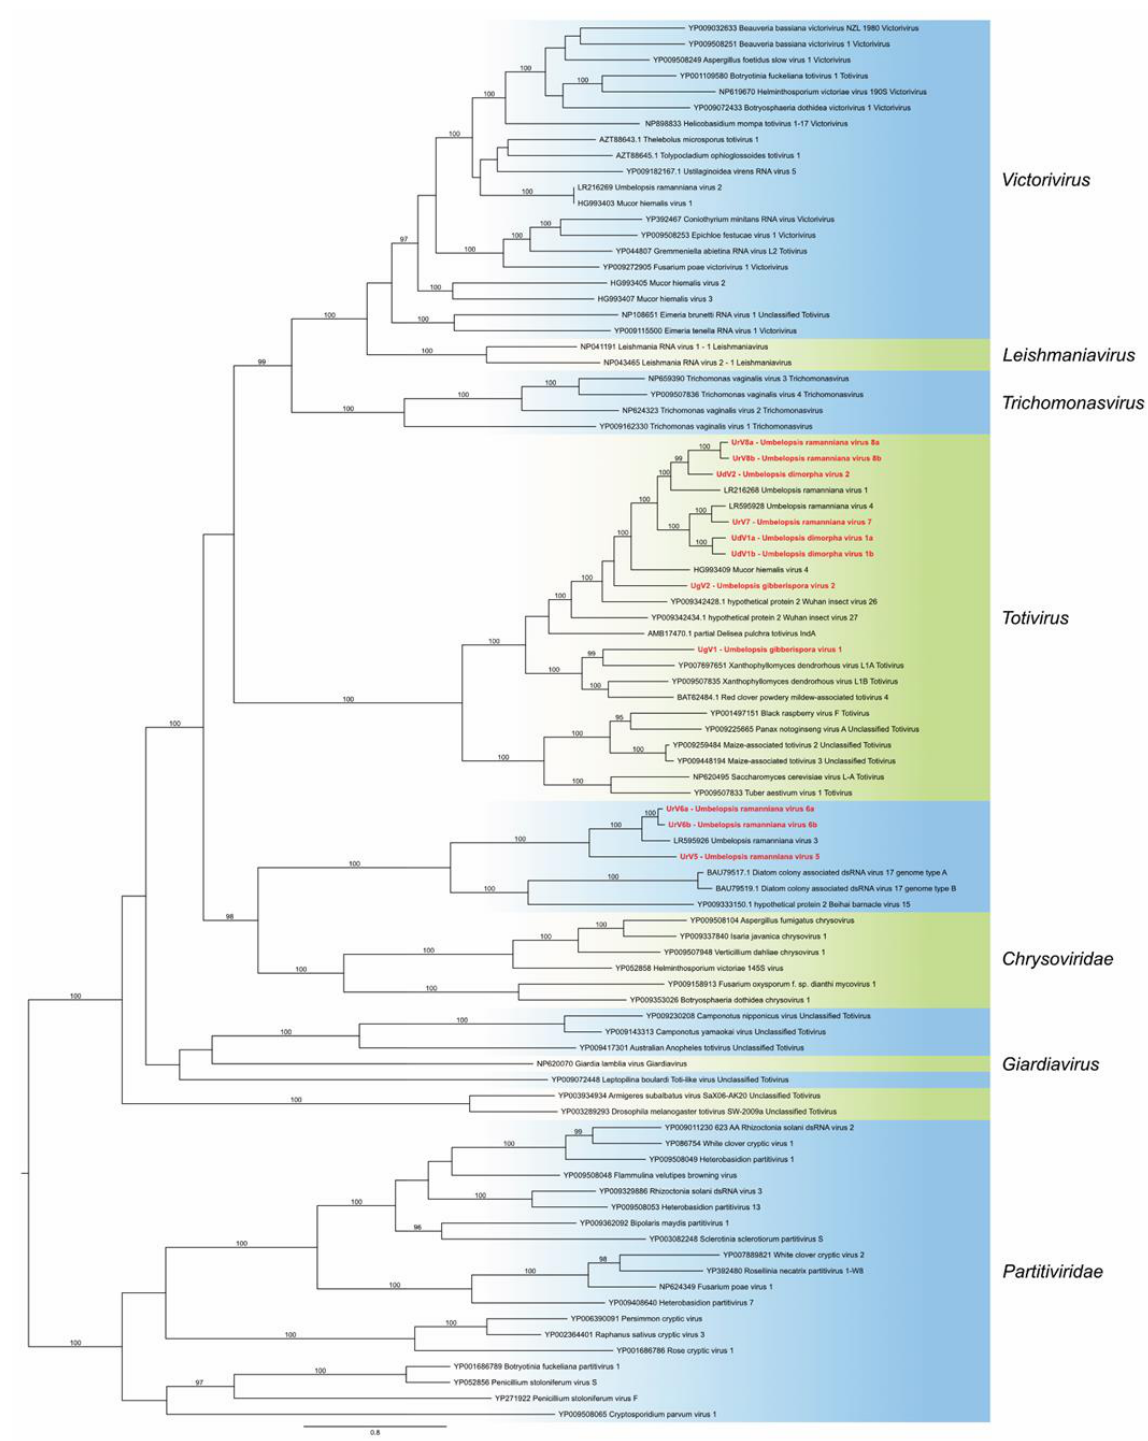
Figure 4. Phylogeny based on the RdRp amino acid sequences from representative members of the families Totiviridae , Chrysoviridae and Partitiviridae . The accession numbers are indicated on the tree. The resulting tree indicates that UdV1a, UdV1b, UdV2, UrV7, UrV8a, UrV8b, UgV1 and UgV2 are members of the genus Totivirus , while UrV5, UrV6a and UrV6b are seated in the well-defined but yet unclassified clade, which is closely related to the Chrysoviridae clade. Only bootstrap values higher than 95% are shown. The novel Umbelopsis mycoviruses are indicated with red